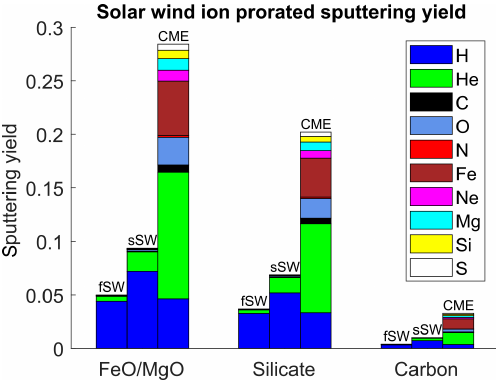
Figure 2. Solar wind ion prorated sputtering yield for Fe 0 . 4 Mg 0 . 6 O, silicate, and carbon. Sputtering yields are a function of solar wind ion itself, its fractional abundance (fast solar wind (fSW), slow solar wind (sSW), and CME), and its mean